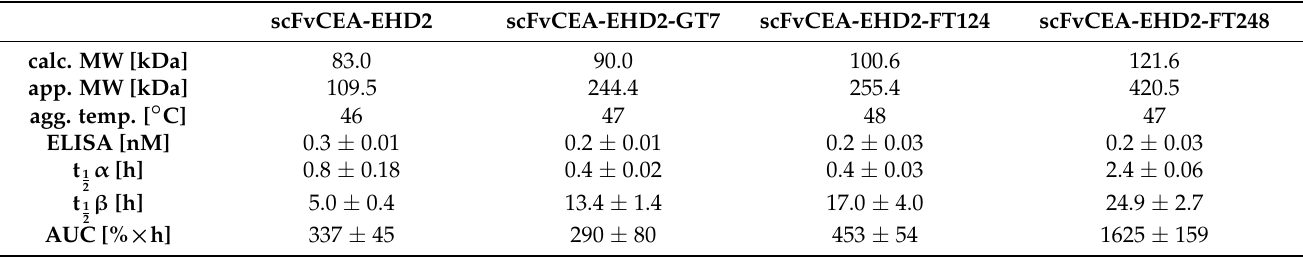
Table 3. Biochemical, binding, and pharmacokinetic properties of scFv-EHD2-based molecules. Mean ± SD, n =